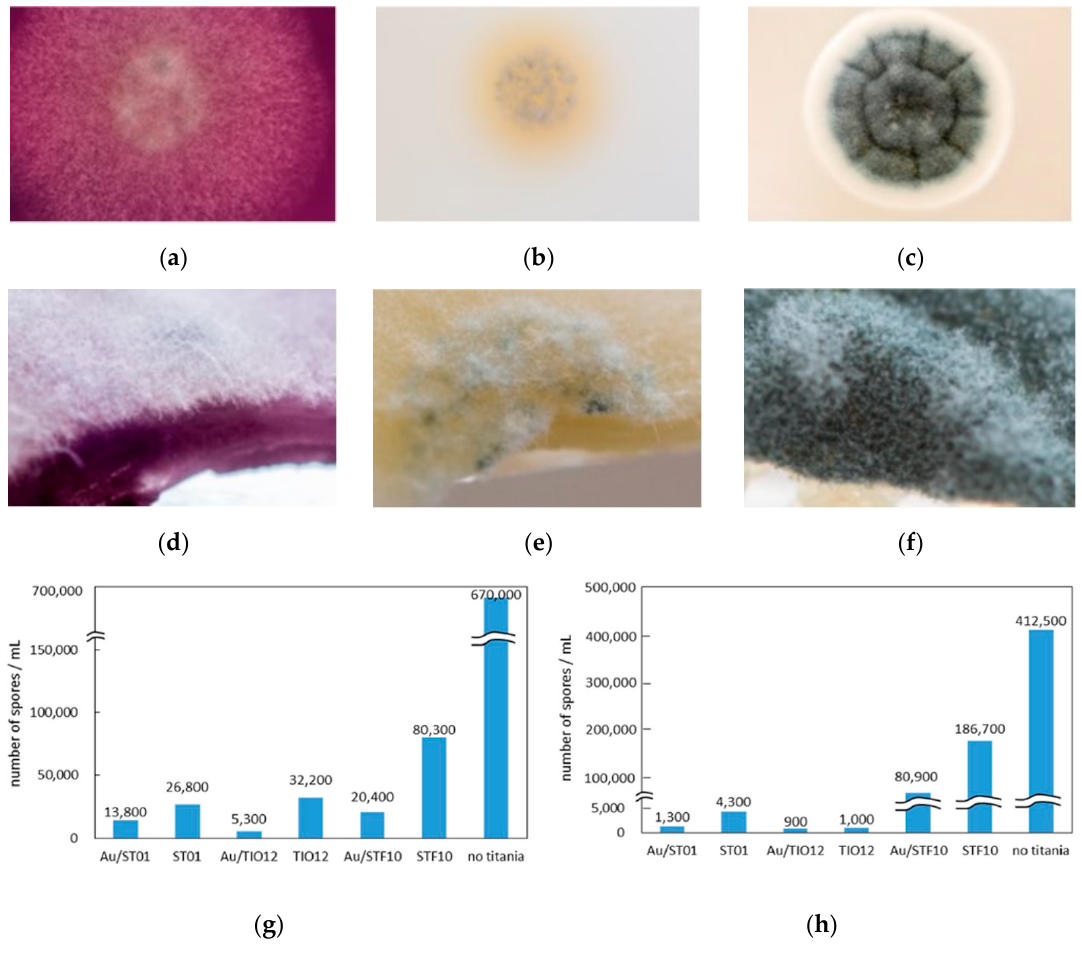
Figure 7. Figure 7. ( a , f ) Representative photographs (top view: ( a – c ), and cross section: ( d – f )) of P. chrysogenum cultivated for four days under fluorescent ‐ light irradiation on: ( a , d ) Au/TiO 2 , ( b , e ) TiO 2 , ( c , f ) without photocatalyst. ( g , h ) Number of spores after five days of growth under vis irradiation for: ( g ) P. chrysogenum and ( h ) A. melleus ; ST01, TIO12 and STF10—different samples of commercial titania— and Au/ST01, Au/TIO12 and AU/STF10—respective titania modified with gold NPs; adapted with permission from [115]. Copyright 2018, Creative Commons Attribution.